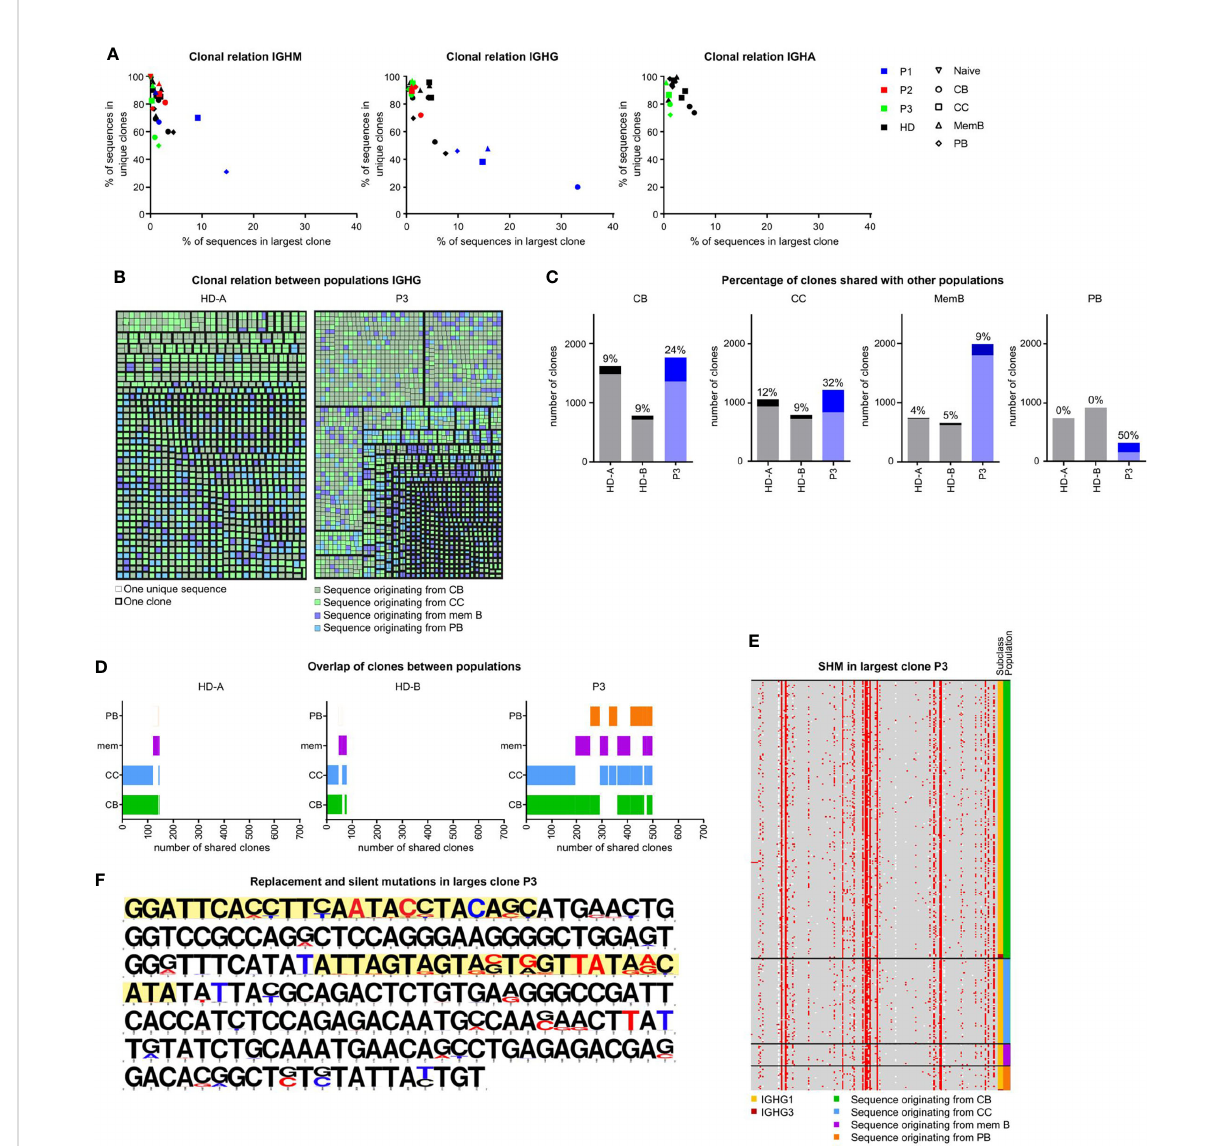
FIGURE 5 Clonal relation between SLO B-cell populations in P3. (A) Clonality of IGHM , IGHG and IGHA transcripts in sorted GC B-cell populations. Samples with little clonality are top left, samples containing one very large clone are bottom left. Samples containing many small clones are bottom right. (B) Clonal relation between IGHG sequences of HDA and P3. Each colored square represents a single unique sequence, with the color representing the population the sequence originates from. The bold border visualizes which sequences are clonally related. (C) The number of clones analyzed in each individual. Clones containing sequences from at least one other population are a darker shade and the percentage is listed on top of each bar. (D) Visualization of clones containing sequences in multiple populations. The overlap in bars visualizes the populations with shared clones. (E, F) Alignment of all sequences of the largest IGHG clone in P3. (E) Locations of SHM are indicated in red. The original population and subclass are indicated. (F) The original sequence is in black and mutations are indicated in red (replacement mutations) or blue (silent mutations). The CDR regions are highlighted in